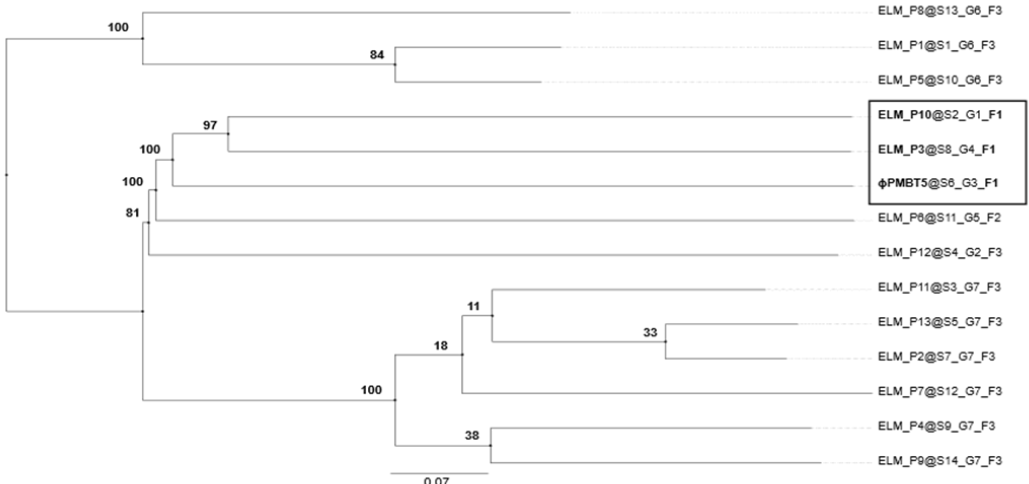
Figure 4. Phylogenomic tree of ELM phages [25] (metagenomicly predicted E. lenta phages) and PMBT5 based on genome-wide BLAST distances with an average support of 69%. Numbers on the tree represent pseudo-bootstrap values from 100 replications. The black square marks the ELM phages that are predicted to be within the same family (F1) as PMBT5. S = species, G = genus, F = family, and associated numbers indicate predicted groupings.